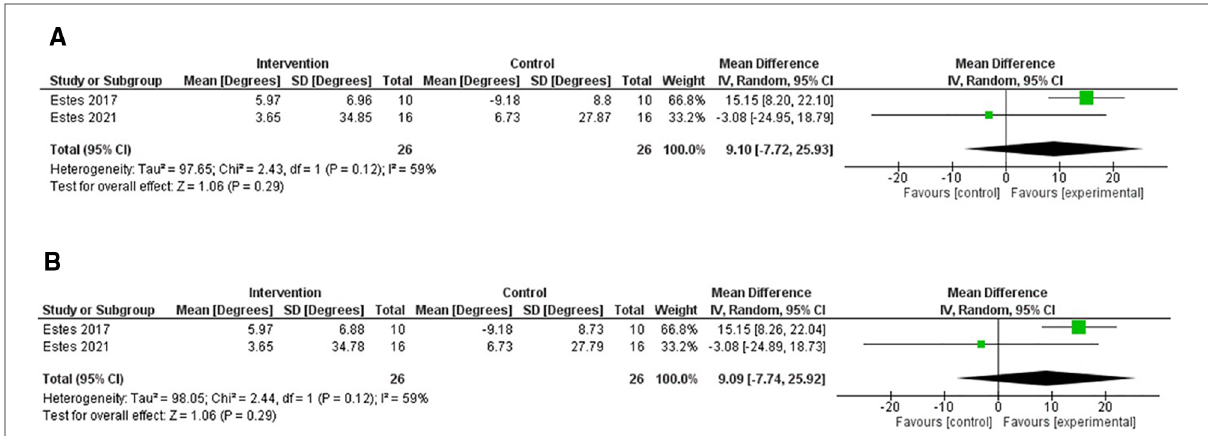
FIGURE 4 Forest plot using a random effects model of RCT studies using the FSE. The black diamond represents the average effect of non-invasive electrical stimulation. ( A ) shows results for Corr=0.1 and ( B ) for Corr=0.2. CI=con fi dence interval, FSE= fi rst swing excursion, RCT=randomised-control